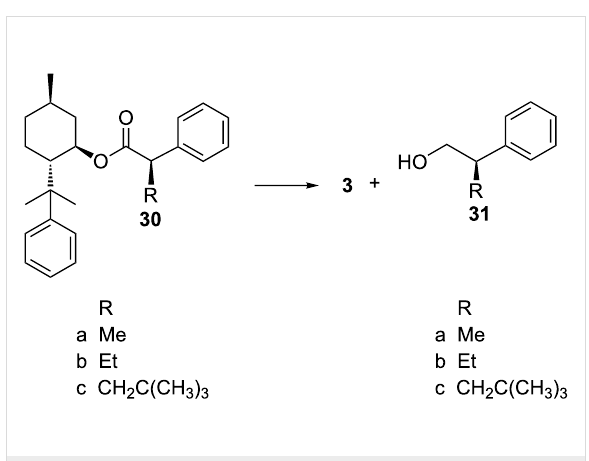
Scheme 5: Reductive cleavage of 30a–c to 8-phenylmenthol ( 3 ) and 31a–c